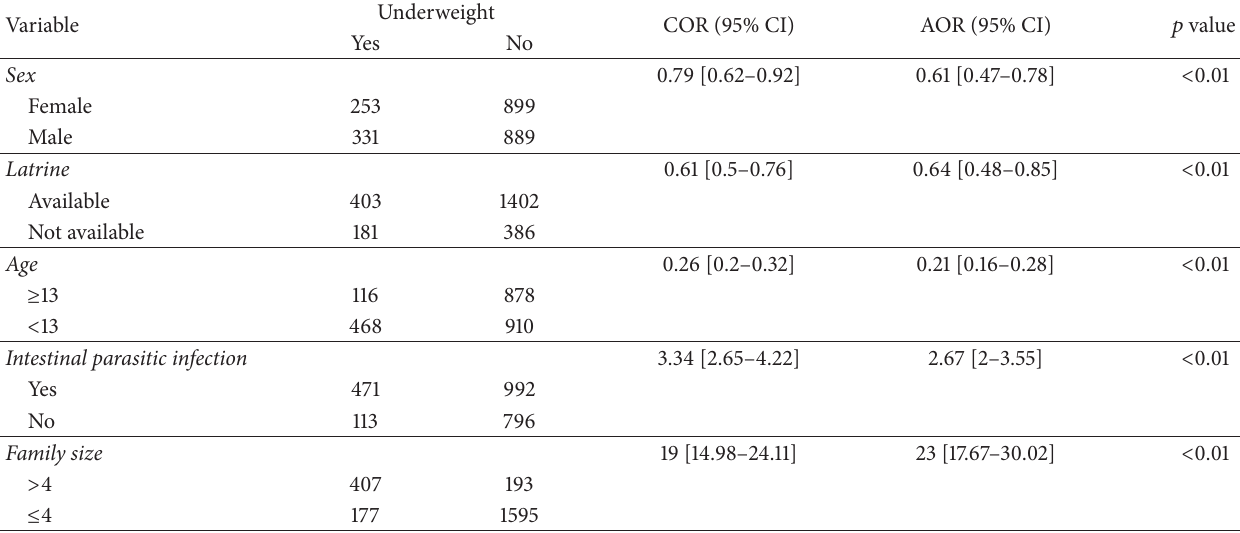
Table 2: Predictors of underweight in school age children ( 𝑛 = 2372 ).